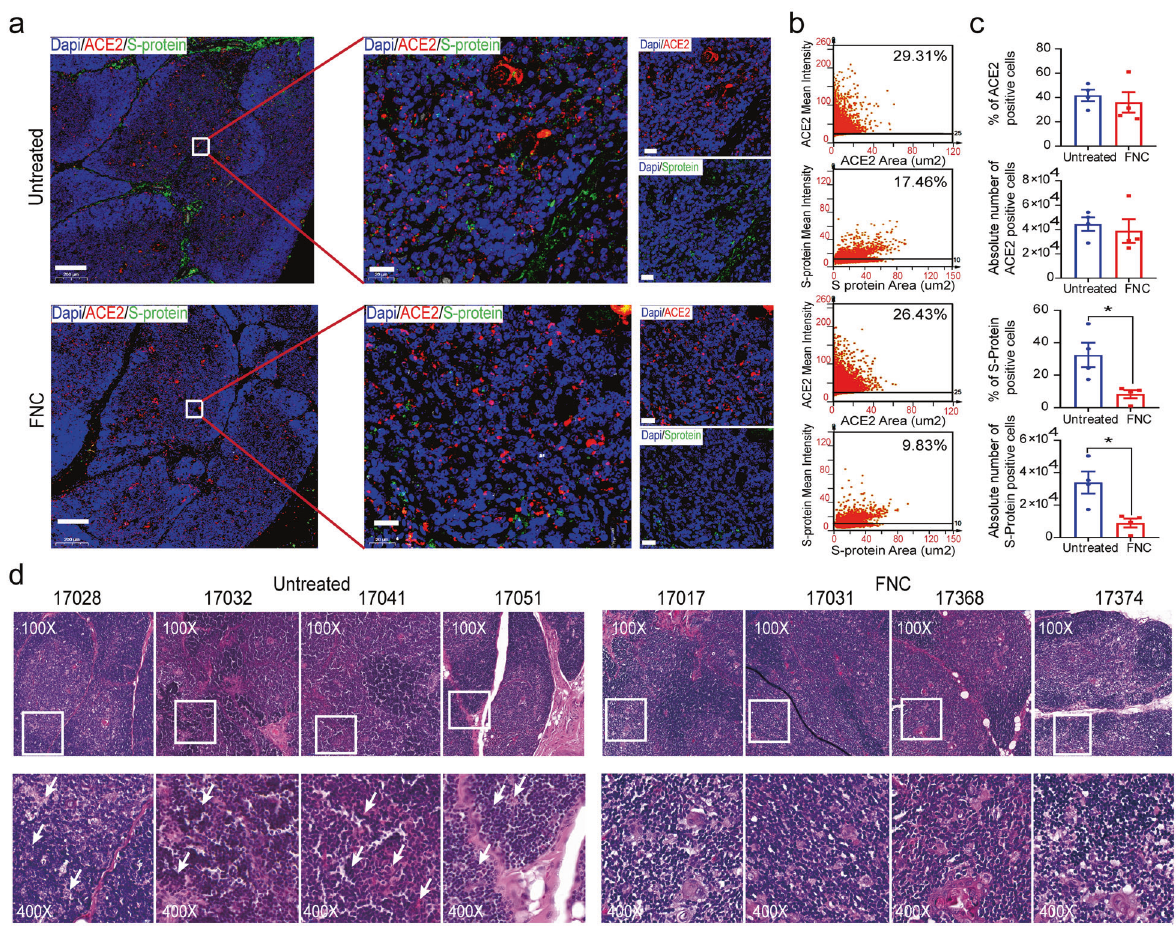
Fig. 5 FNC-protected thymus from the damage by SARS-CoV-2 infection. By the end of the experiment, the RM monkeys have practiced euthanasia, and the thymus samples were collected. a The representative images of the multi-color immuno fl uorescent staining were for ACE2 (red) and S protein (green) in the thymus of the RM monkeys that were inoculated with SARS-CoV-2 and treated or untreated with FNC. The regions of interest (ROI) are boxed in white, and their magni fi ed photos are shown in the middle, with a decomposition diagram on the right. Scale bars, 200 µm (left) and 20 µm (middle and right). b Representative images of tissue fl ow cytometry analysis, using Tissue FAXS platform and Tissue Quest software (Tissue Gnostics), showed that S-protein positive cells were decreased by FNC. c Statistical results of ACE2 and S-protein positive cells in the thymus of the FNC-treated group and the untreated one ( n = 4 for each group) showed that FNC signi fi cantly reduced the cells infected with SARS-CoV-2. d FNC alleviated in fi ltration, effusion, and structure damage (white arrows) in the thymus of the FNC-treated virus ( + ) monkeys. The regions of interest (ROI) are boxed in white, and their magni fi ed photos are shown below. Data are presented as mean ± SEM ( n = 4), * p < 0.05, FNC-treated group vs. untreated group, by Mann – Whitney U test expression of nine important pathways through a comparison between FNC-treated (code# 17368) and untreated (code# 17041) viral ( + ) monkeys. The pathways involved in T-cell activation, T-cell-activation-involving immune response, innate immune response, positive regulation of immune system process (Fig. 7b), response to the virus (Fig. 7c), and IL-4, IL-10, and IL-13 production (Fig. 7d) were analyzed in fi ve major types of cells including CD4 + , CD8 + , NKT cells, monocytes, and B cells. We found that in all fi ve types of thymus cells, the T-cell activation signal was elevated signi fi cantly by FNC, particularly in CD4 + and CD8 + cells. The signal for the T-cell-activation-involving immune process was also elevated, particularly in CD4 + and CD8 + cells and monocytes. The signal for innate immune response in the thymus was signi fi cantly promoted by FNC, but mainly in CD4 + cells only. For positive regulation of the immune system process, the signal was largely increased in all fi ve types of cells. The sign for response to the virus after FNC treatment was improved only in CD4 + cells. These results showed the promotion of intracellular pathways for the immune or antiviral response in the major types of cells in the thymus. Signal Transduction and Targeted Therapy (2021)